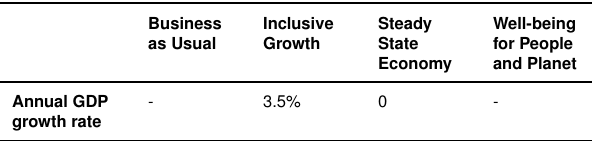
Table 2. Exogenous annual GDP growth rate in different scenarios.